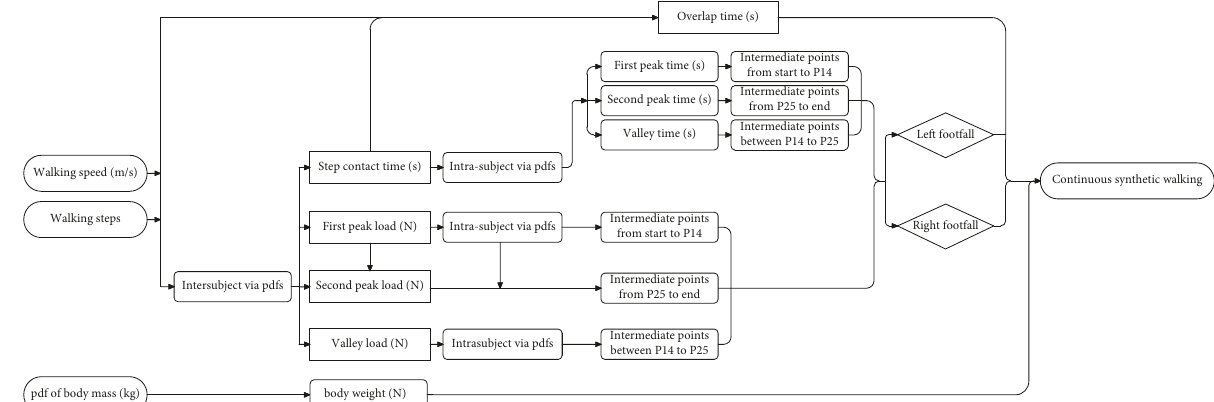
Figure 12: Schematic flow chart describing the procedure for generating synthetic continuous walking.